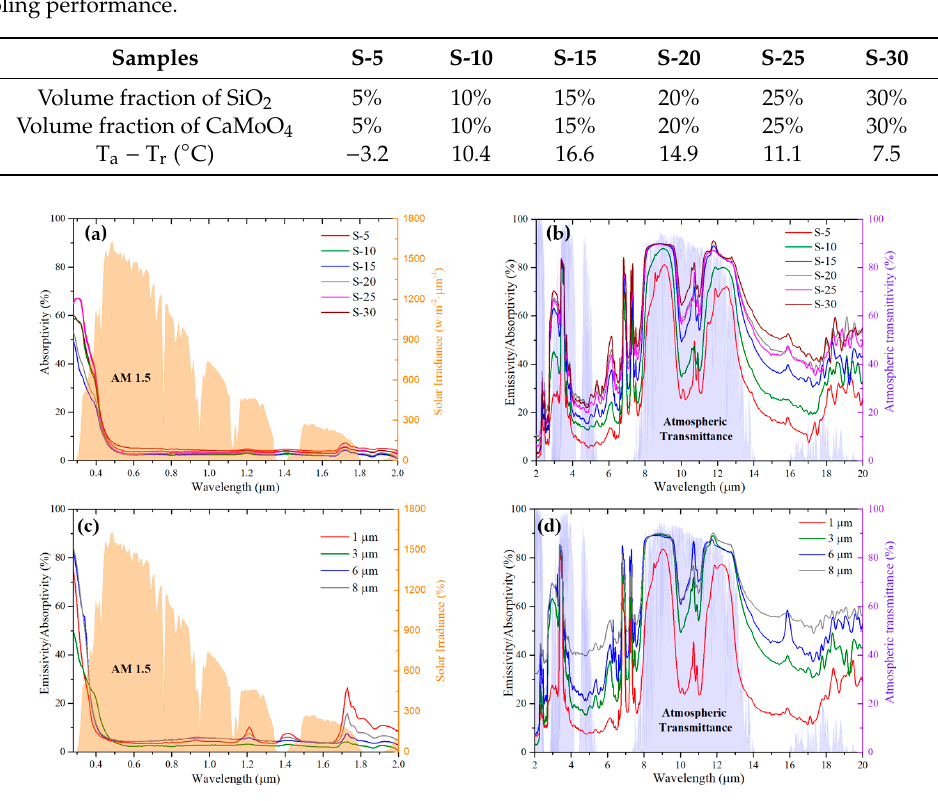
Figure 4. ( a ) Solar absorptivity and ( b ) IR emissivity/absorptivity of the samples with a different nanoparticle volume fraction. ( c ) Solar absorptivity and ( d ) IR emissivity/absorptivity of the samples with different film thicknesses.